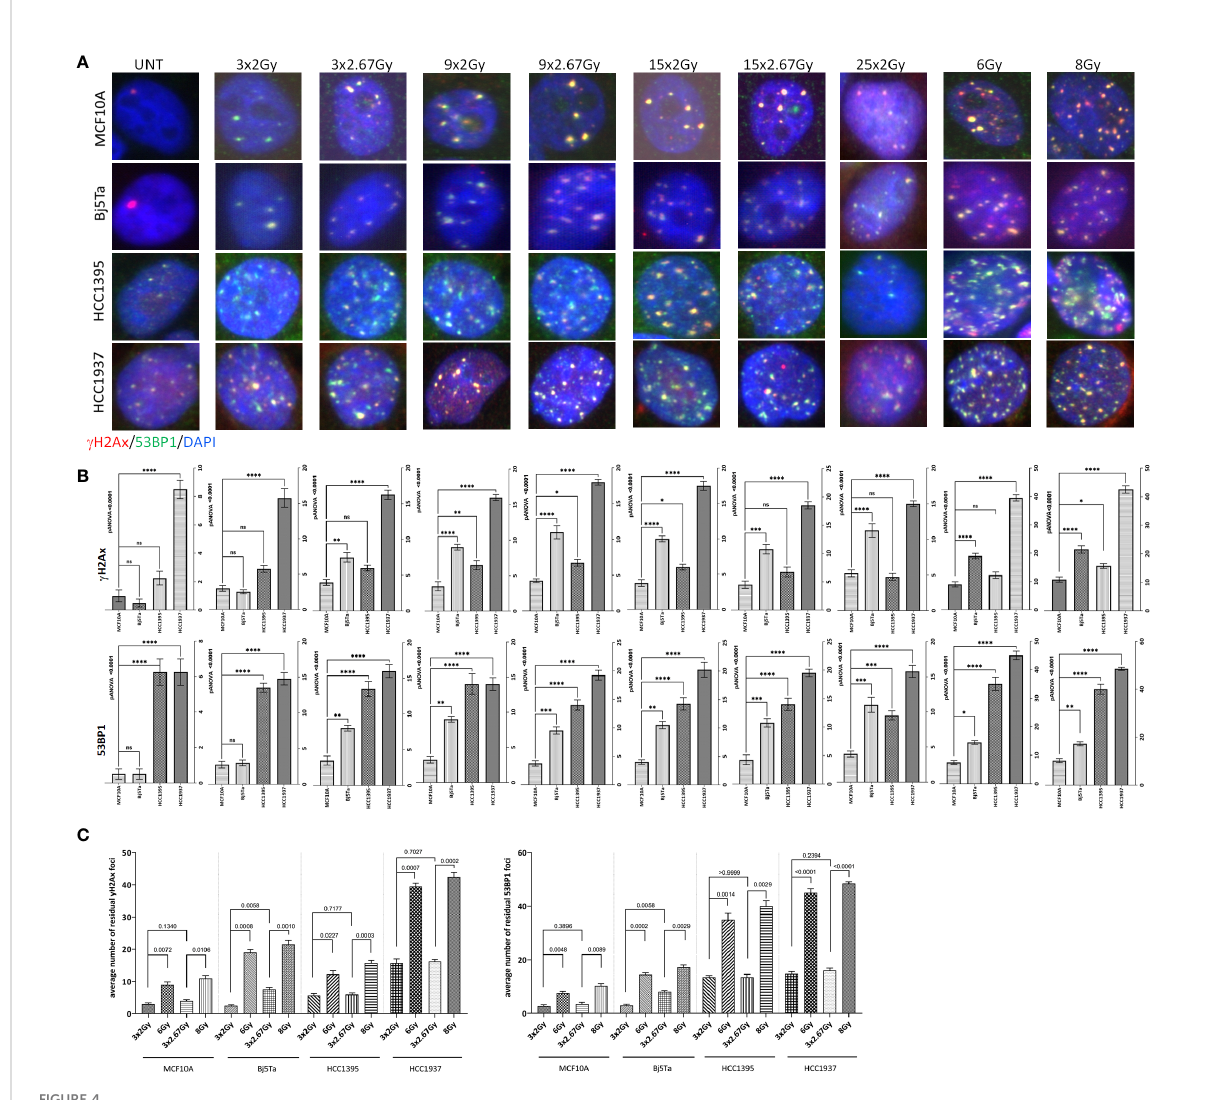
FIGURE 4 Immunocytochemical analysis of residual DNA damage foci after fractionated irradiation with the corresponding protocols. Representative images of residual g H2AX foci (red) and 53BP1 foci (green) double immunostaining (A) and evaluation (B, C) of g H2AX foci (top on B and left on C) and 53BP1 foci (bottom on B and right on C) 24 h after systematic irradiation with HypoRT or NormRT protocols at days 3, 9, 15, and 25 (NormRT only), using conventional fl uorescence microscopy (Leica DMI6000B). DNA is counterstained with DAPI (UNT – untreated value “ age-matched ” to day 25). Evaluation data are presented as bar plots of average foci number (+/- SEM) per cell per slide from two slides. Values of 6 Gy and 8 Gy represent single-dose controls for fractionated irradiation with the NormRT or HypoRT protocol, respectively, at irradiation day 3. (B) Comparison of average residual DNA damage foci numbers between different cell lines and MCF10A cells. (C) Comparison of average residual DNA damage foci numbers ( g H2AX and 53BP1) within the cell lines after fractionated irradiation (three fractions with respective protocols) and after a single dose of 6 Gy or 8 Gy, respectively. *p<0.05, **p<0.005, *** p<0.0005, **** p<0.0001, n.s, non-signi fi